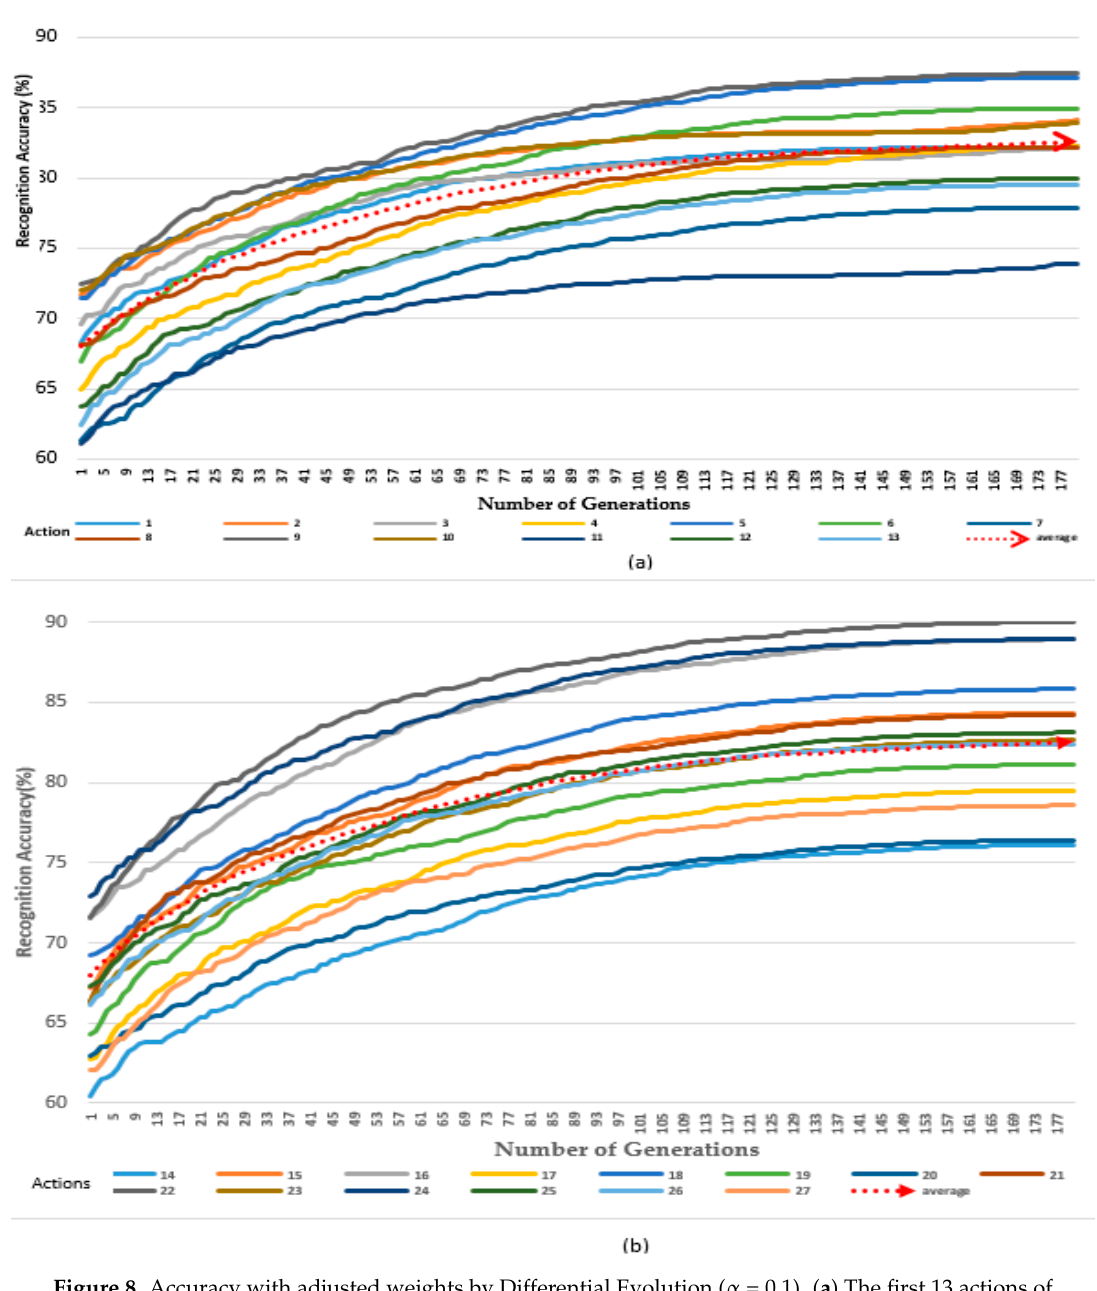
Figure 8. Accuracy with adjusted weights by Differential Evolution ( α = 0.1). ( a ) The first 13 actions of Figure 2. Accuracy with adjusted weights by Differential Evolution ( α = 0.1). (a) The first 13 actions the datasets (1 to 13), ( b ) the last 14 actions of the datasets (14 to of the datasets (1 to 13), (b) the last 14 actions of the datasets (14 to 27).